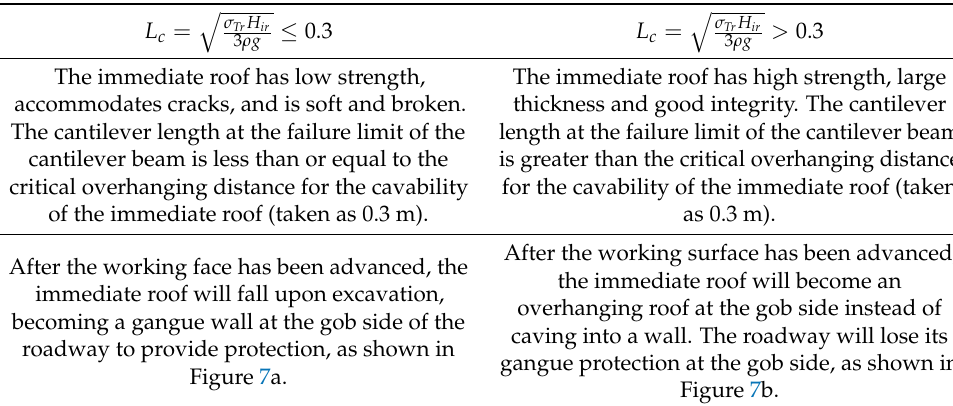
Table 1. Determination of immediate roof cavability [40].